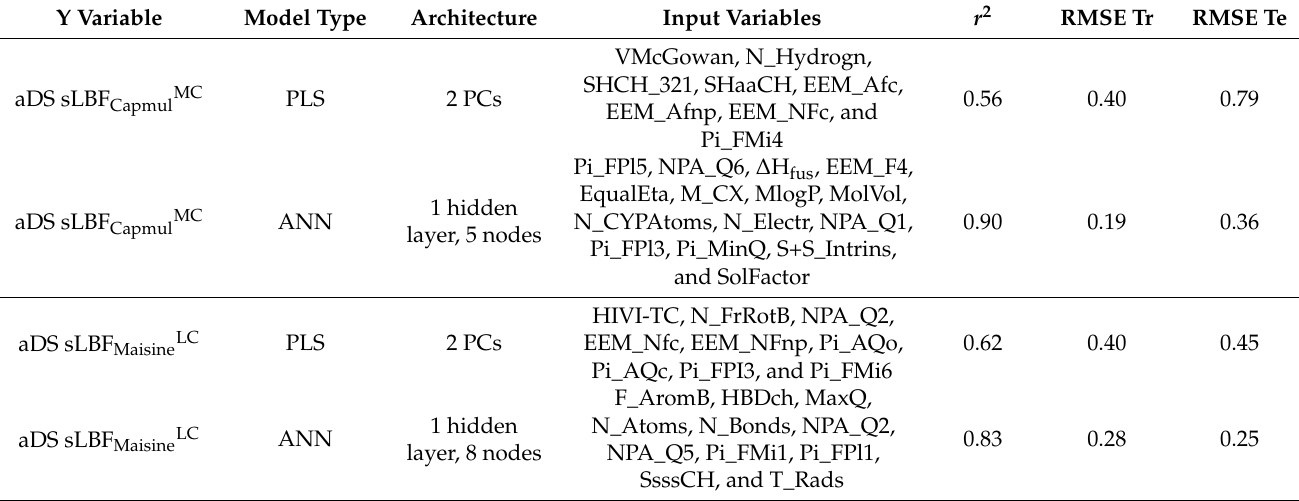
Table 2. Overview of the ANNs produced to predict aDS for sLBF CapmulMC and sLBF MaisineLC from their drug properties, including their architecture and various performance indicators. Tr and Te refer to the training and test